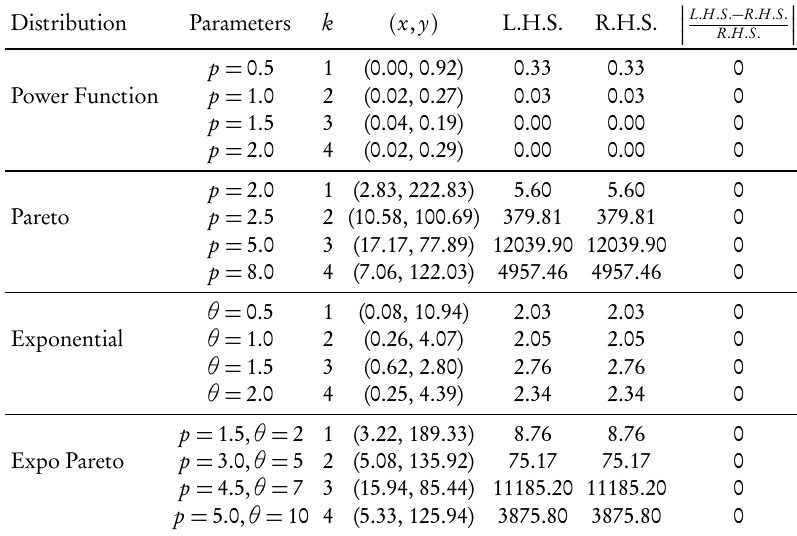
Verification of the characterization